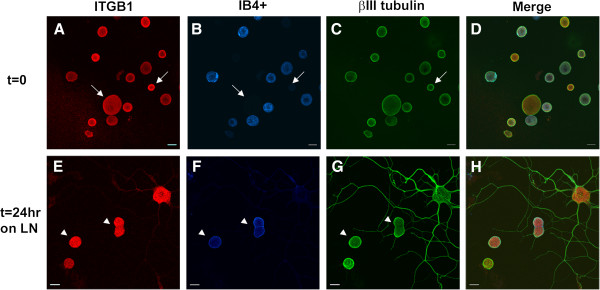
Integrin β1 protein expression in DRG neurons. Dissociated DRG neurons were immunostained for integrin β1 (red), neuron-specific βIII tubulin (green) and IB4 lectin labeling (blue) at t=0 (A-D) and t=24LN (E-H). Both IB4+ and IB4- neurons express Integrin β1 and densitometry indicated that the IB4+ cells had somewhat lower levels of expression. Scale bar-20 μm.